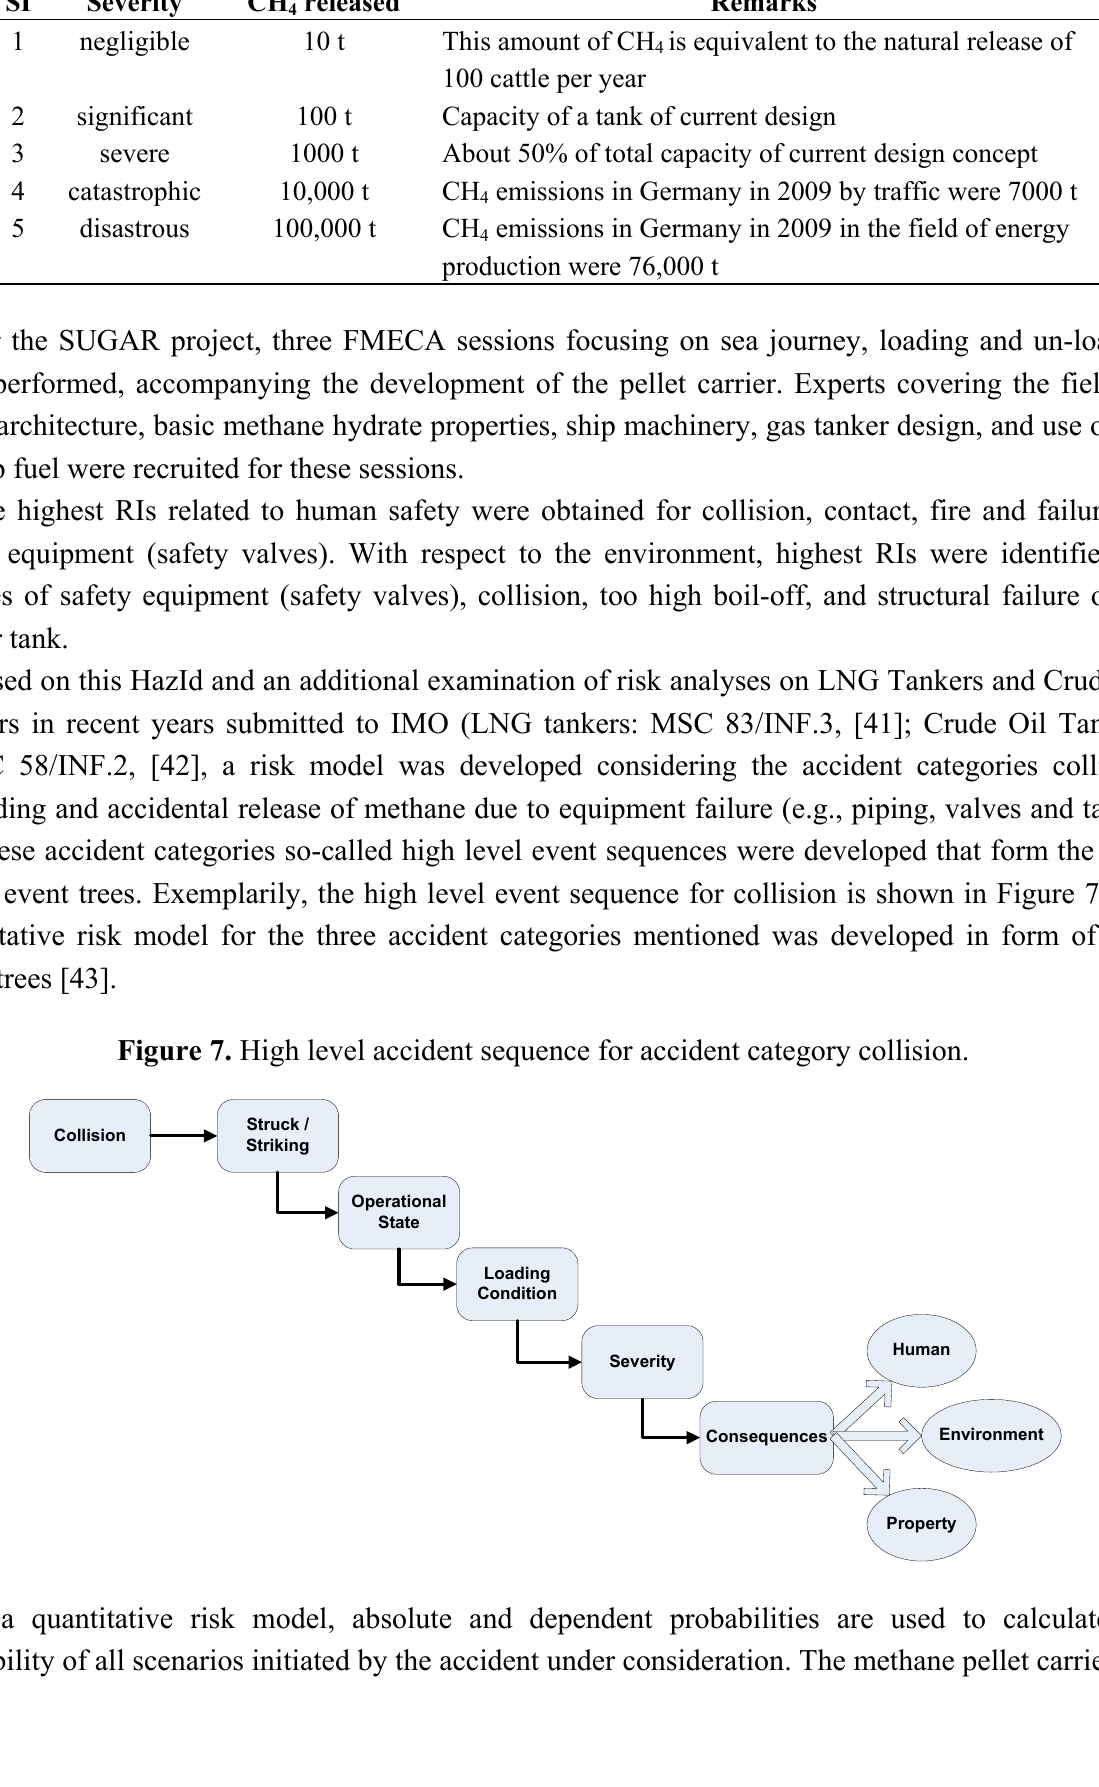
Table 2. Severity Index table for CH